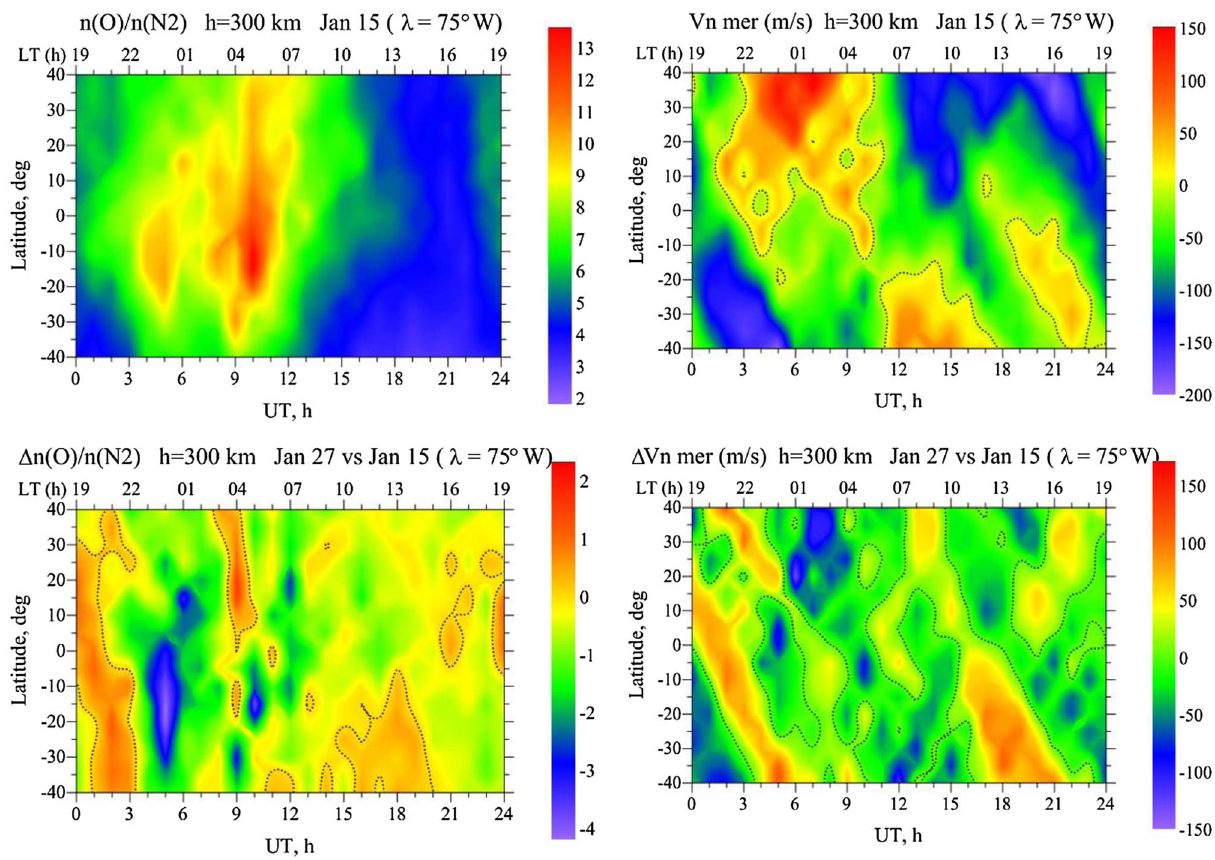
Fig. 6. EAGLE-simulated diurnal variation of the latitudinal pro fi le of O/N 2 ratios (left) and meridional thermospheric winds (right) on 15 January 2009 (top panel) and their disturbances on 27 January 2009 (bottom panel) at the latitude range from 40 (cid:3) S to 40 (cid:3) N in the American longitudinal sector (75 (cid:3) W) and 300 km altitude.